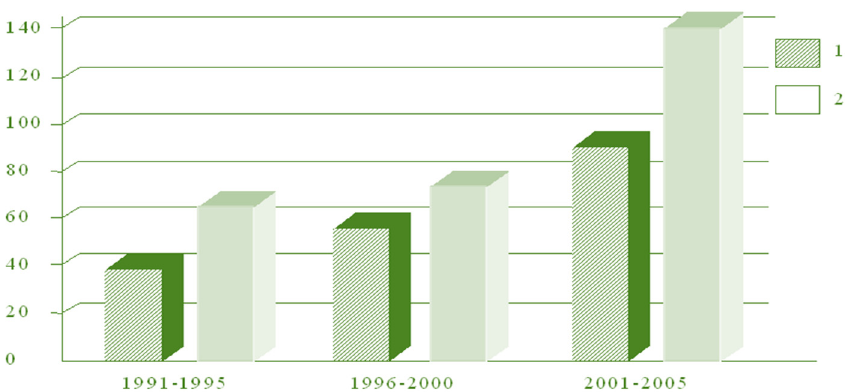
Figure 4. Tendency for electric power system (EPS) blackout problems [25]. (1) The number of outages affecting more than 50,000 consumers; (2) The number of outages greater than 100